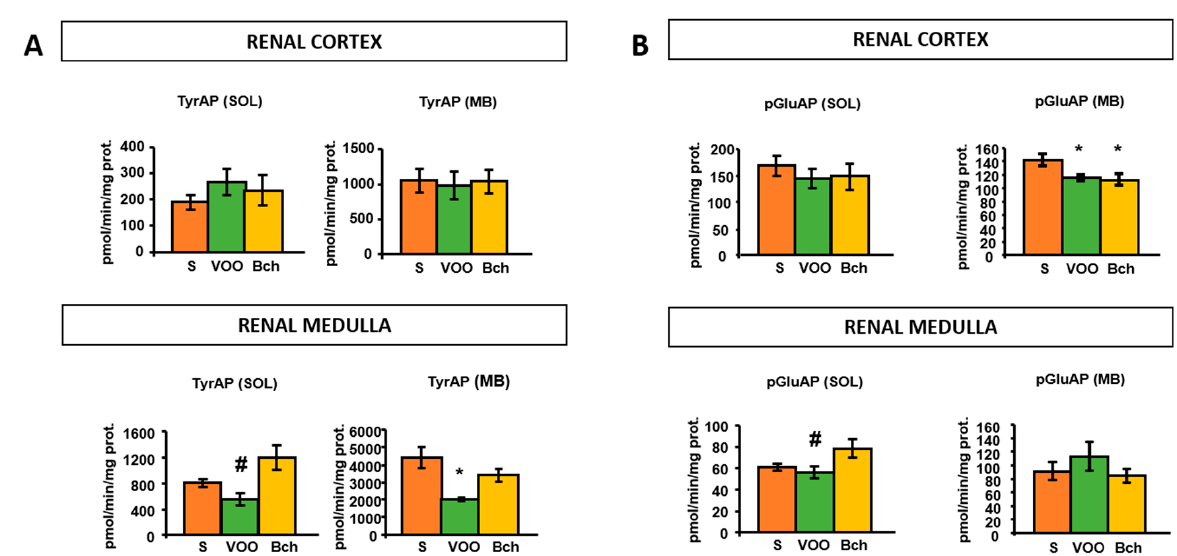
Figure 3. Mean values ± standard errors of ( A ) tyrosyl aminopeptidase activity (TyrAP) and ( B ) pyroglutamyl aminopep- tidase activity (pGluAP) in soluble (SOL) and membrane-bound (MB) fractions of renal cortex and medulla, expressed as pmol/min/mg prot. * indicates significant differences between VOO or Bch vs. S, * p < 0.05. # indicates significant differ- ences between VOO and Bch, # p < 0.05.